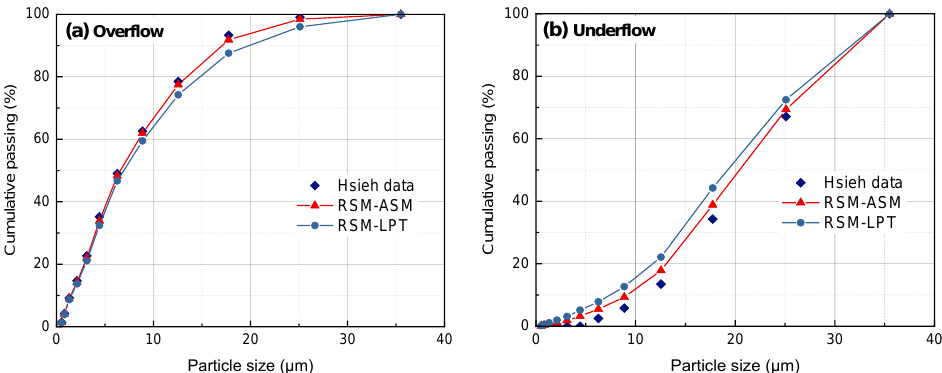
Figure 5. Comparison of particle size distribution in products of the Φ 75 mm hydrocyclone. ( a )— Overflow product; ( b )—Underflow product